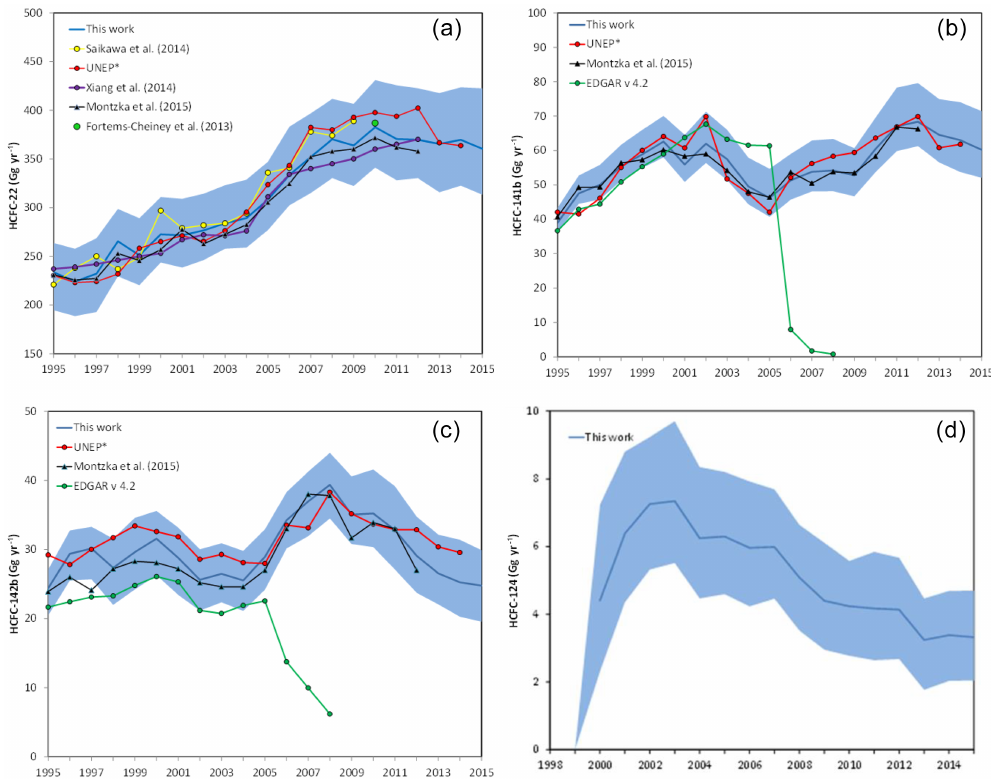
Figure 3. Global HCFC emissions (Ggyr − 1 ) from the 12-box model (solid blue line); shading represents 1 σ uncertainties. Emissions calculated from UNEP data (see Supplement). EDGAR v4.2 and other works are also shown. Note that for HCFC-124 we only use GC-MS- Medusa data for these calculations; for all others we use combined GC-MS-ADS and GC-MS-Medusa